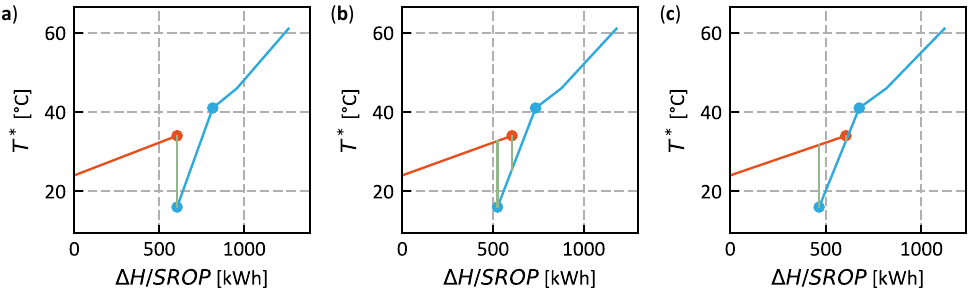
Figure 3. ISSP with different IHR initial solutions for the demonstration case: ( a ) no IHR; ( b ) with 80 kWh IHR; and ( c ) with 140 kWh